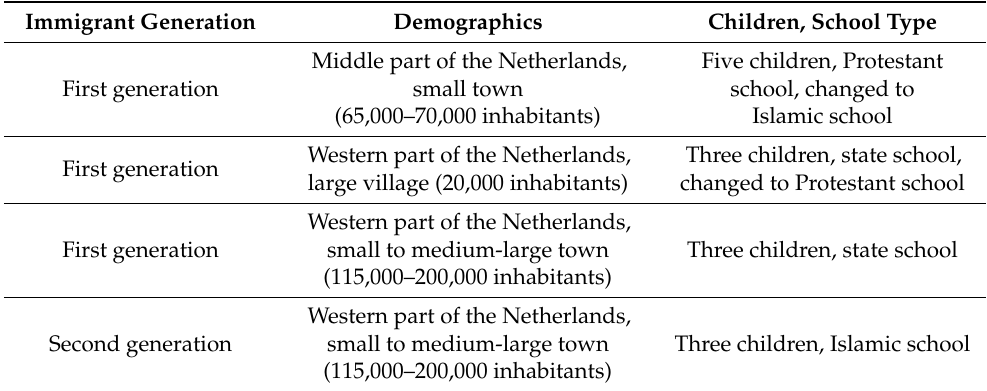
Table 1. Characteristics of participants 1